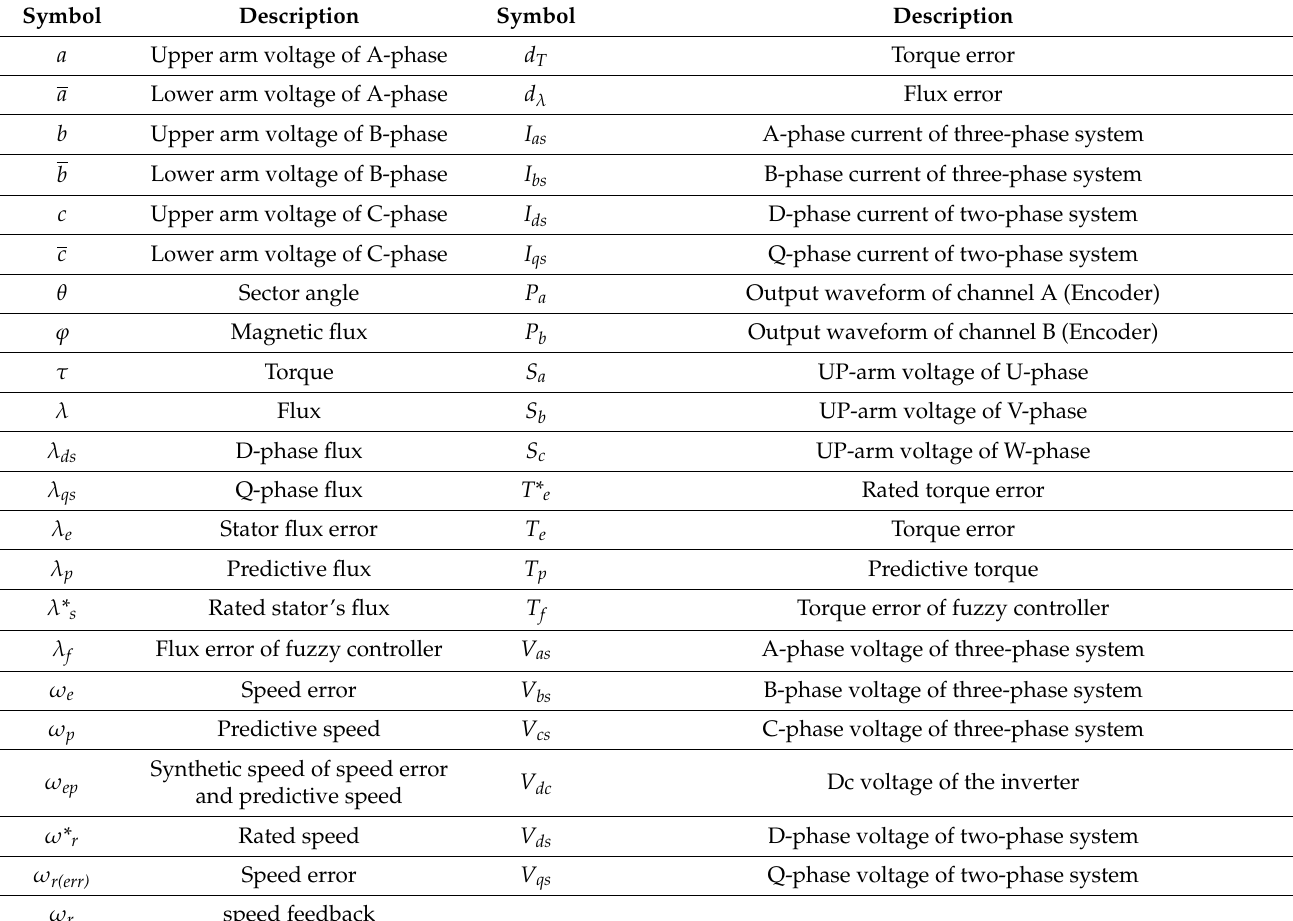
Table A1. All symbols used in the block diagram of the proposed MPDTC ASIC (Figure